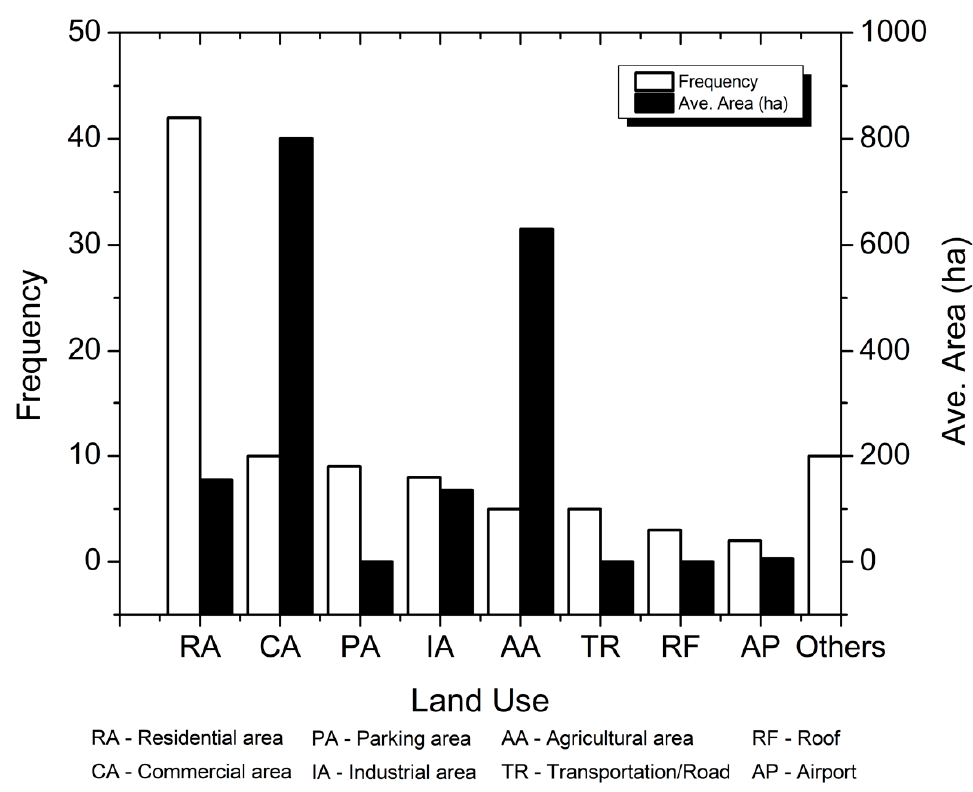
Figure 5. Frequencies of each land use in the reviewed research articles and their respective average area.